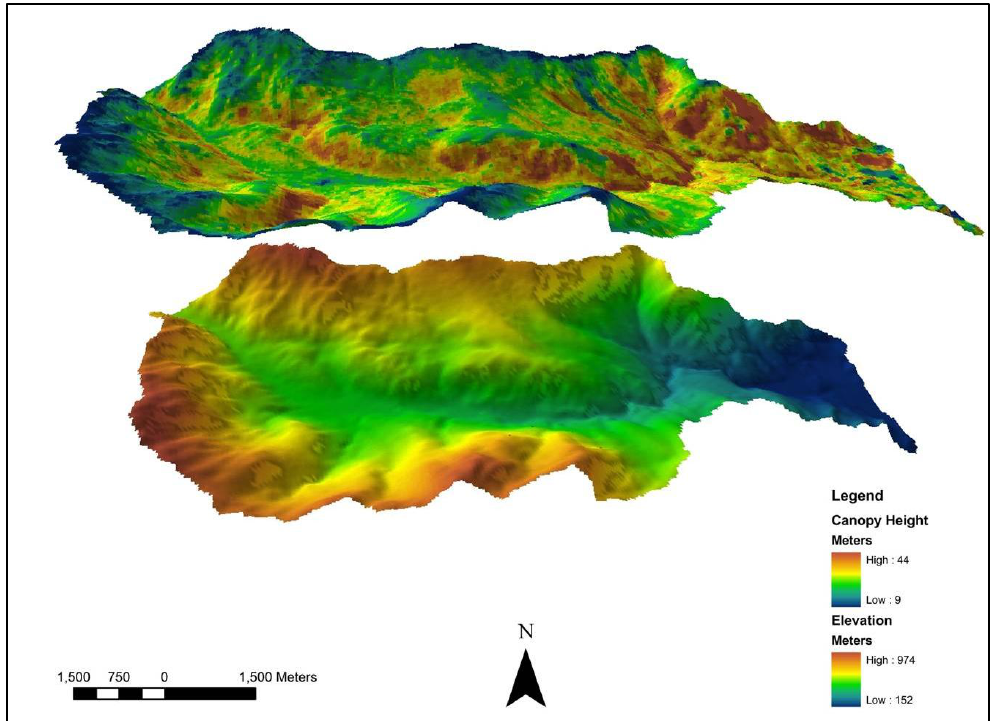
Figure 2. 3-D illustration of Hubbard Brook Experimental Forest. The upper image shows variation in lidar derived canopy height, and the lower image shows the elevation across the study